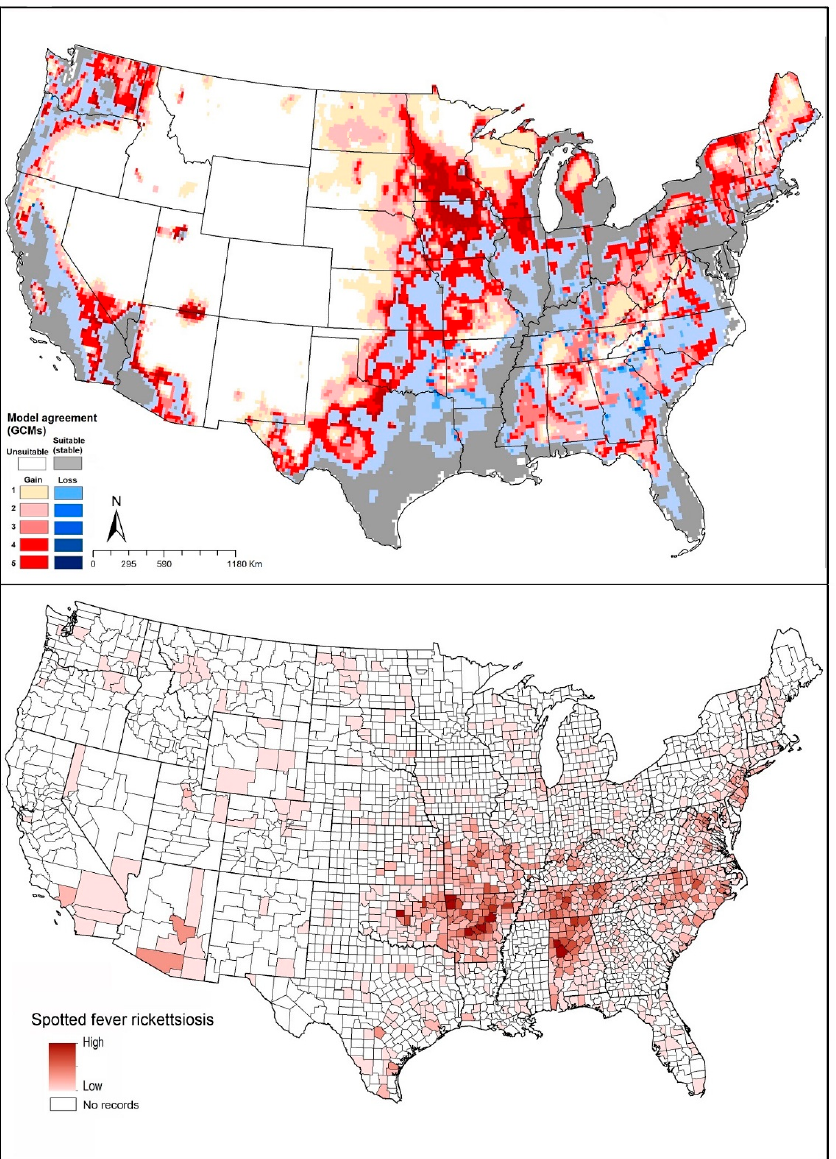
Figure 6. Geographic distribution of Rhipicephalus sanguineus and the disease that it likely transmits in the United States. Dark pink represents high incidence, light pink indicates low incidence. White represents no records. 4.1.5. Amblyomma maculatum (Gulf Coast Tick)